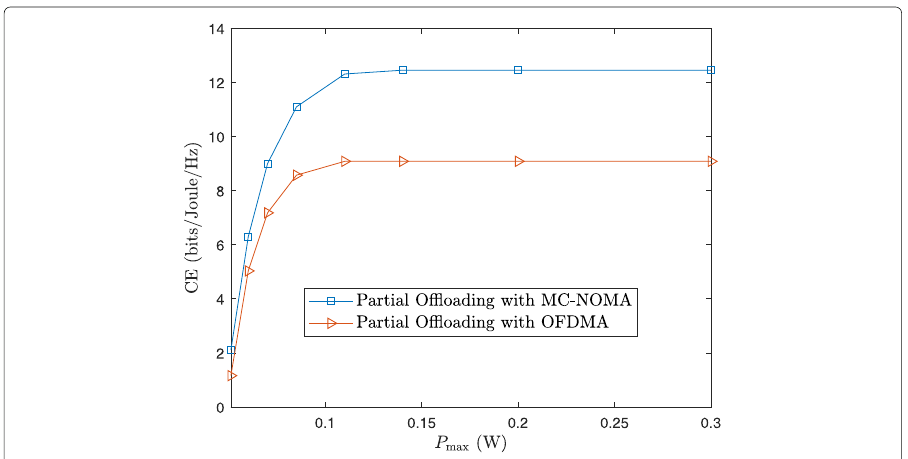
Fig. 8 Comparison of CEs under partial offloading mode with MC-NOMA and